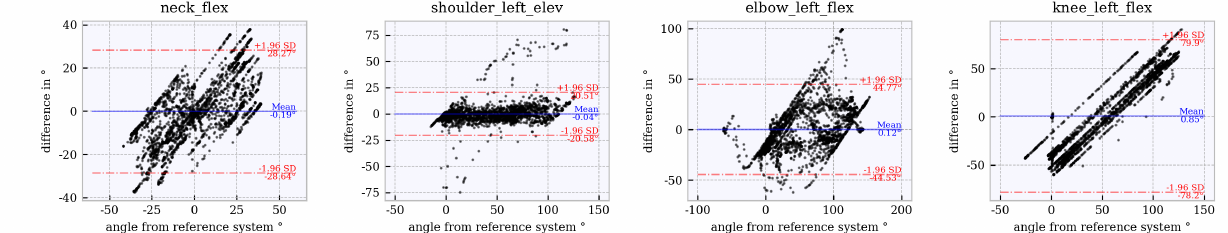
Figure 13. Bland–Altman plot for tracker configuration 4 ; x does not show the average of both systems but the joint angles of the reference system, Qualisys.